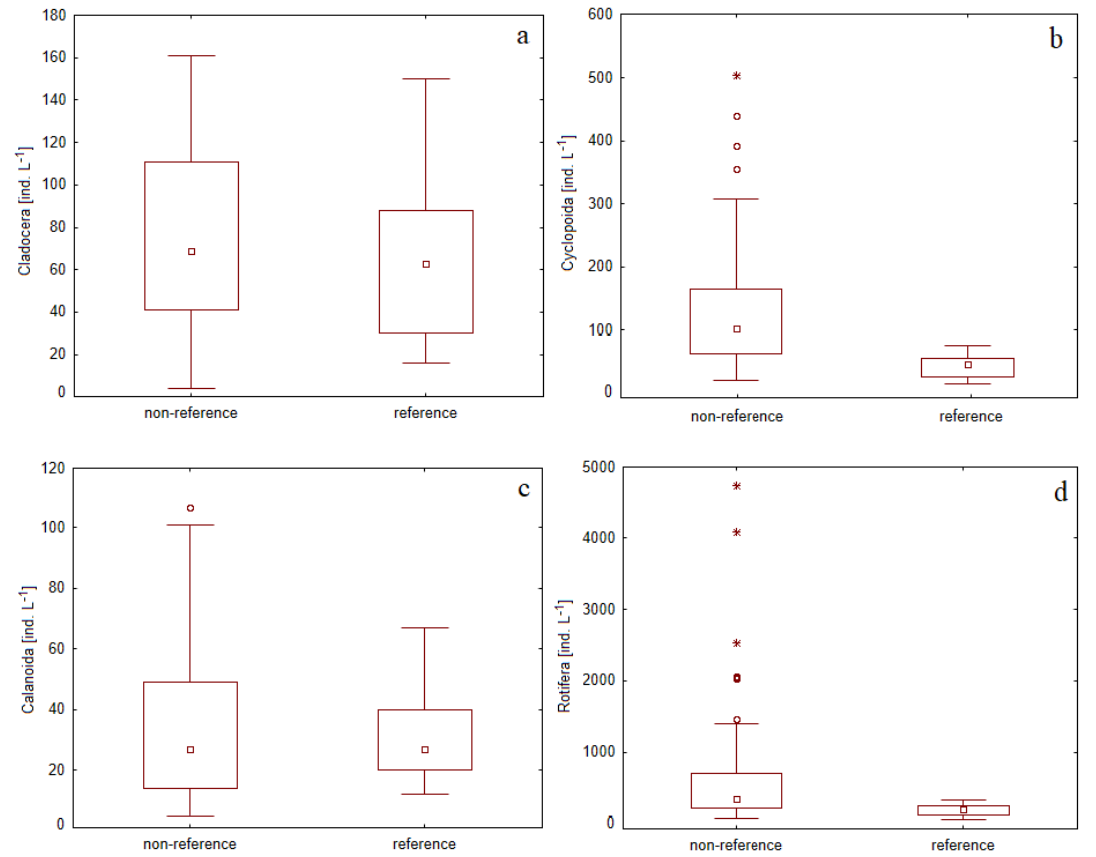
Figure 2. Distribution of ( a ) Cladocera, ( b ) Cyclopoida, ( c ) Calanoida, ( d ) Rotifera abundance (ind. L −1 ) in reference (n = 17) and non-reference (n = 69) lakes. Boxplots present 25 – 75th percentiles with median (squares), whiskers are range,circles are outliers, and asterisks are extreme values. The mean total biomass of planktonic Crustacea and Rotifera was lower in the refer- ence lakes than in the non-reference lakes (Z = 2.45; p < 0.05; Z = 2.77; p < 0.01, respectively; Figure 3a,b).